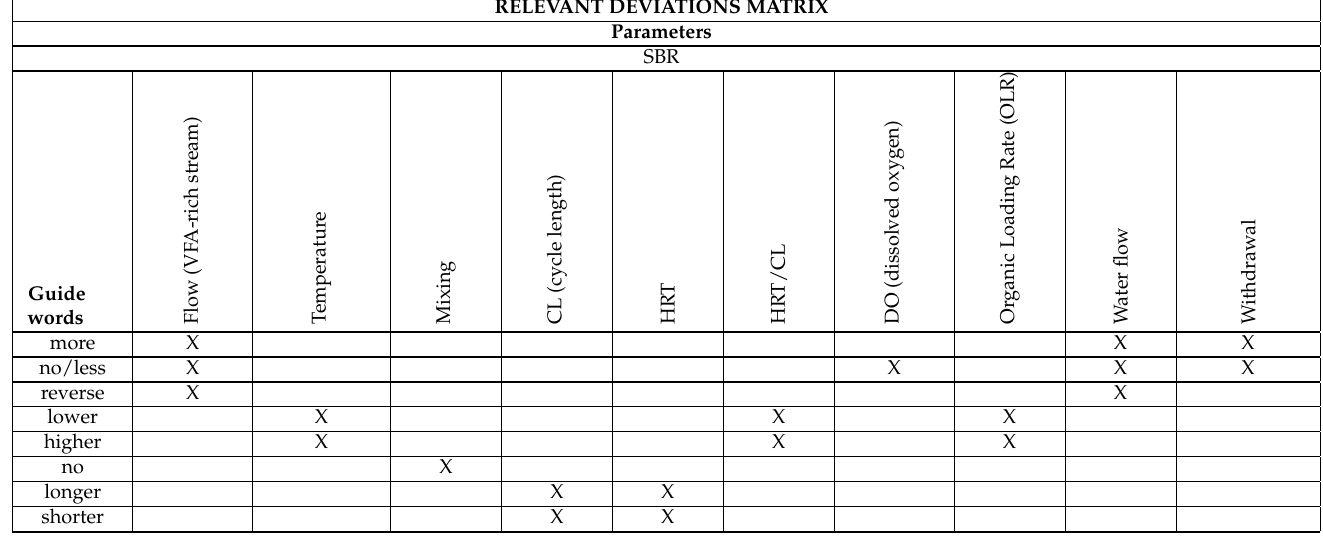
Table A1. Relevant Deviations Matrix (RDM) listing the possible combinations of guidewords and process parameters to be used in BioHazop study (node 2).